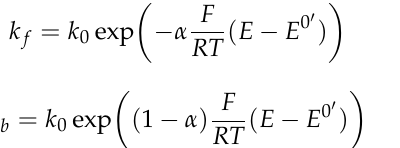
Table 2. The simulation was carried out using the Chemical Reaction Engineering module